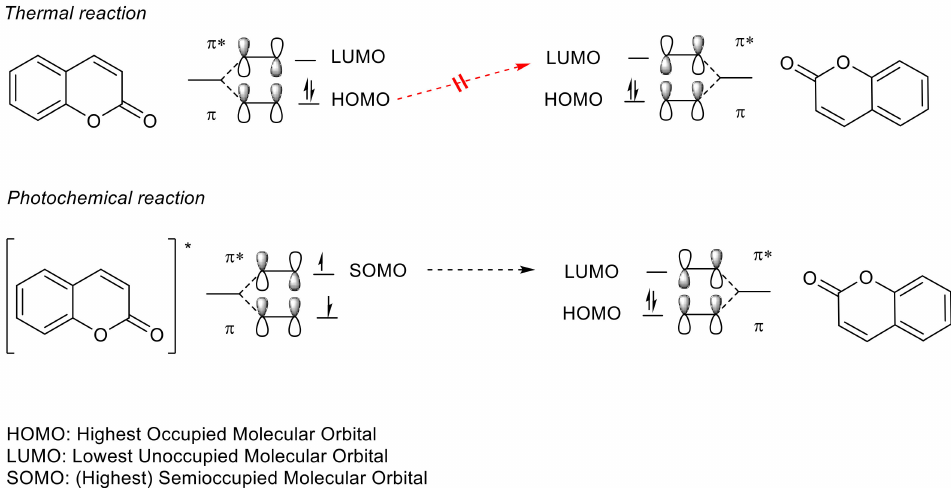
Figure 7. Conservation of orbital symmetry for [2 π s + 2 π s] cycloaddition of coumarin. The asterisk (*) denotes the excited state of the